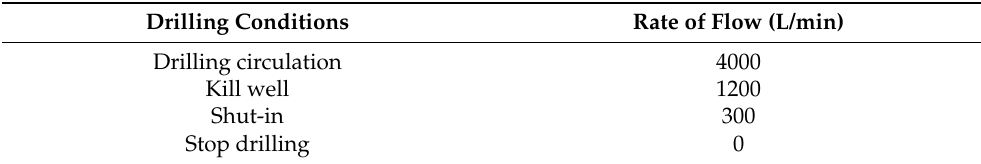
Table 1. Circulation rate at different working conditions.